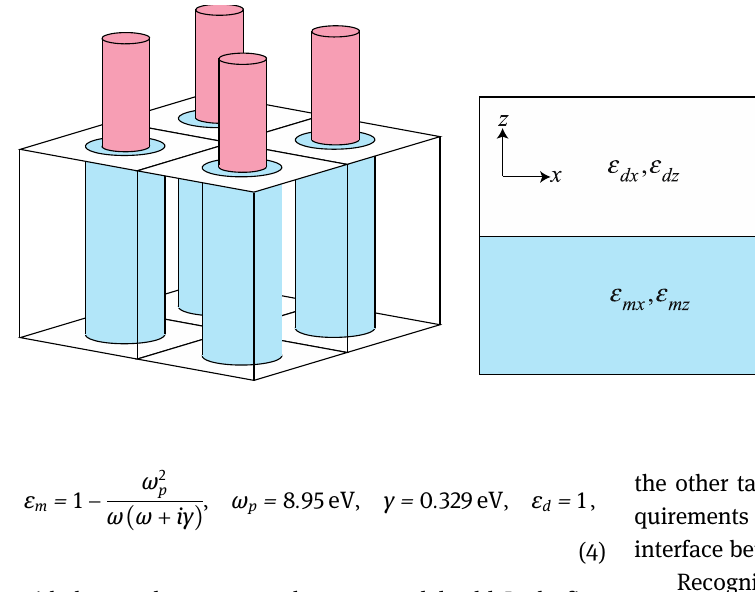
Figure 1: A two-dimensional square array of metallic cylinders much smaller than the relevant wavelengths, embedded in a dielectric. In the plane z = 0, there is an interface between two sets of cylinders.